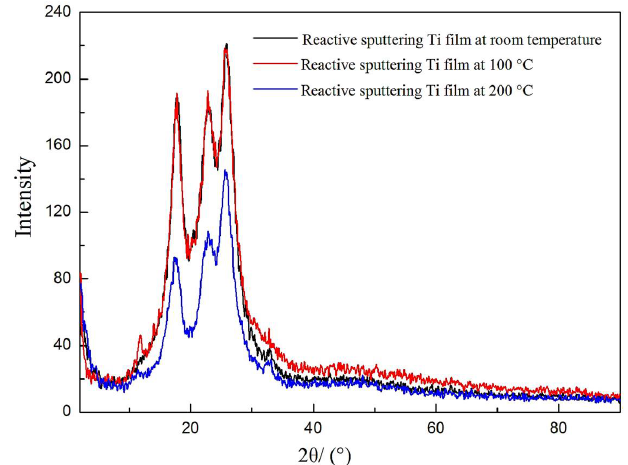
Figure 2. XRD patterns of the sample coated with Al/TiO 2 composite films for reaction sputtering TiO 2 film at different temperature.